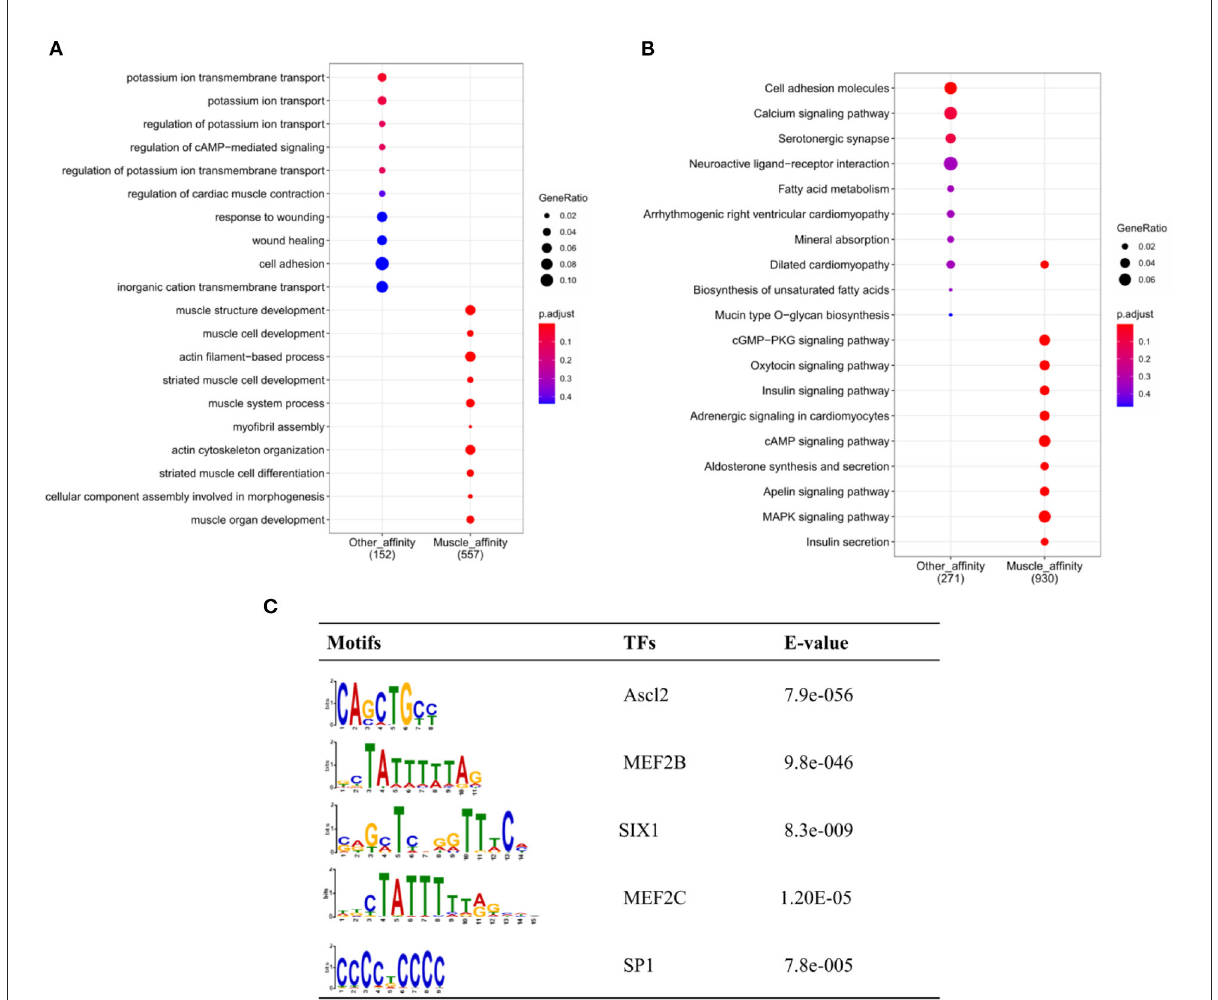
FIGURE6 Genomic enrichment analysis. (A) GO-BP analysis of different peaks; (B) Enrichment analysis of KEGG pathway; (C) The top 5 predicted binding known motif in the open chromatin